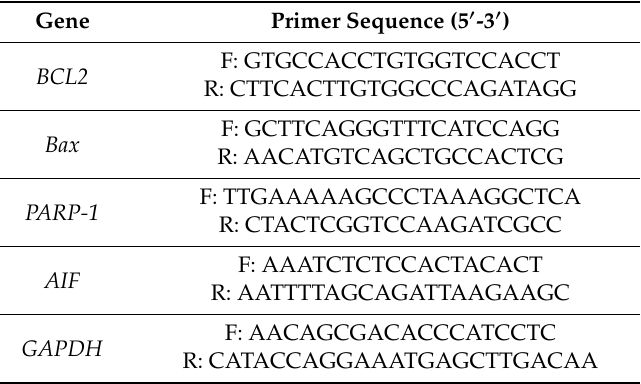
List of primer sequences for BCL-2-like protein 4( Bax ), B-cell lymphoma 2 ( BCL2